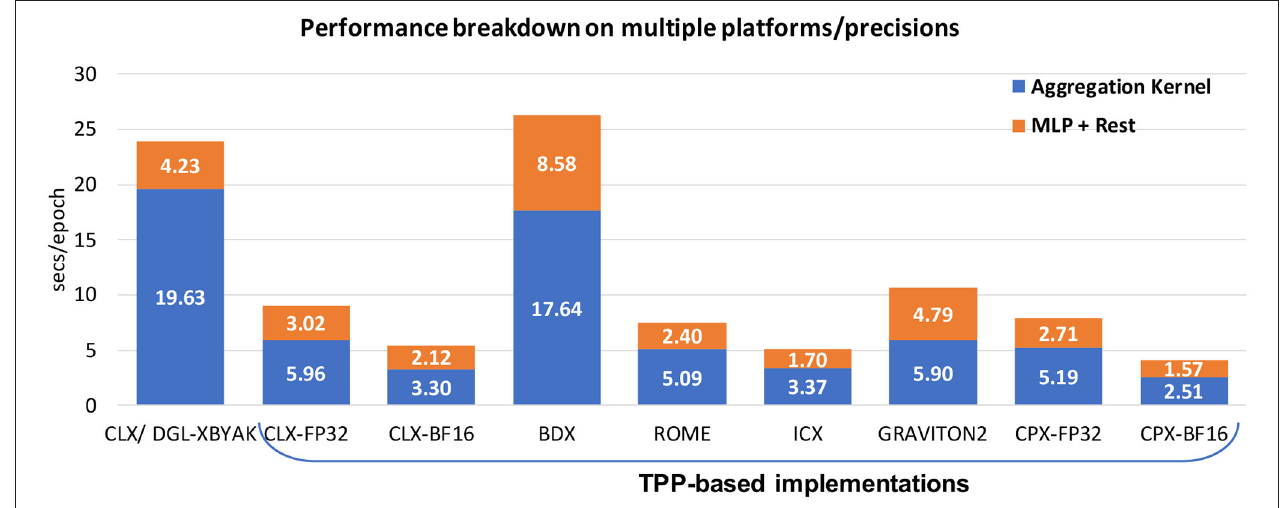
FIGURE 29 | GNN performance breakdown of GaphSAGE Full-batch training for